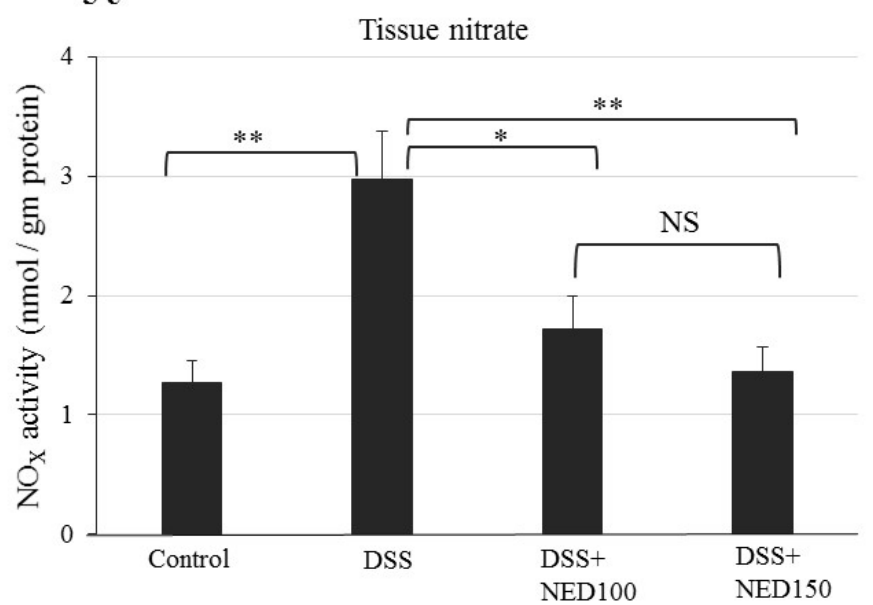
Figure 5. E ff ect of NED on inflammatory mediator COX-2 and inducible oxide synthase (iNOS) protein and mRNA expression and tissue nitrate levels. NED-treatment significantly inhibited the DSS-induced expression of COX-2 and iNOS at both the protein ( a , b ) and mRNA levels ( c , d ) and also reduced the tissue nitrate levels ( e ). Data were obtained from n = 4 animals for Western blot and n = 6 animals for mRNA expression and tissue nitrate level studies in each group and expressed as means ± SEM. *** p ≤ 0.001. ** p ≤ 0.01. * p ≤ 0.05; p values were obtained by one-way ANOVA followed by Tukey’s multiple comparison test using SPSS software, and p ≤ 0.05 was considered statistically significant.